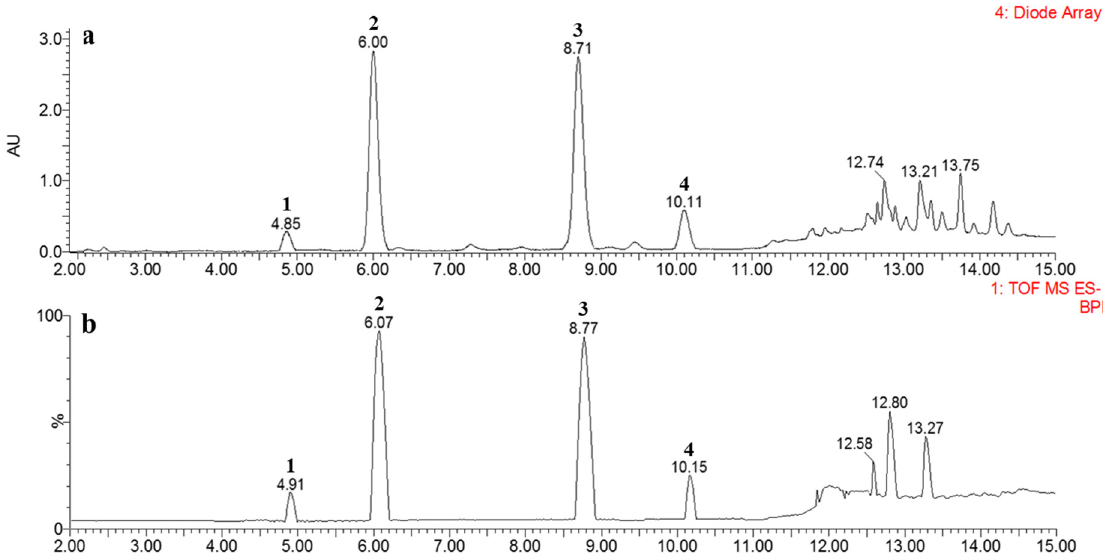
Figure 3. Representative chromatograms of EtOAc rhizome extract of Dryopteris crassirhizoma . ( a ) Diode array detector (DAD) chromatogram and ( b ) total ion current-base peak intensity (TIC-BPI) chromatogram.